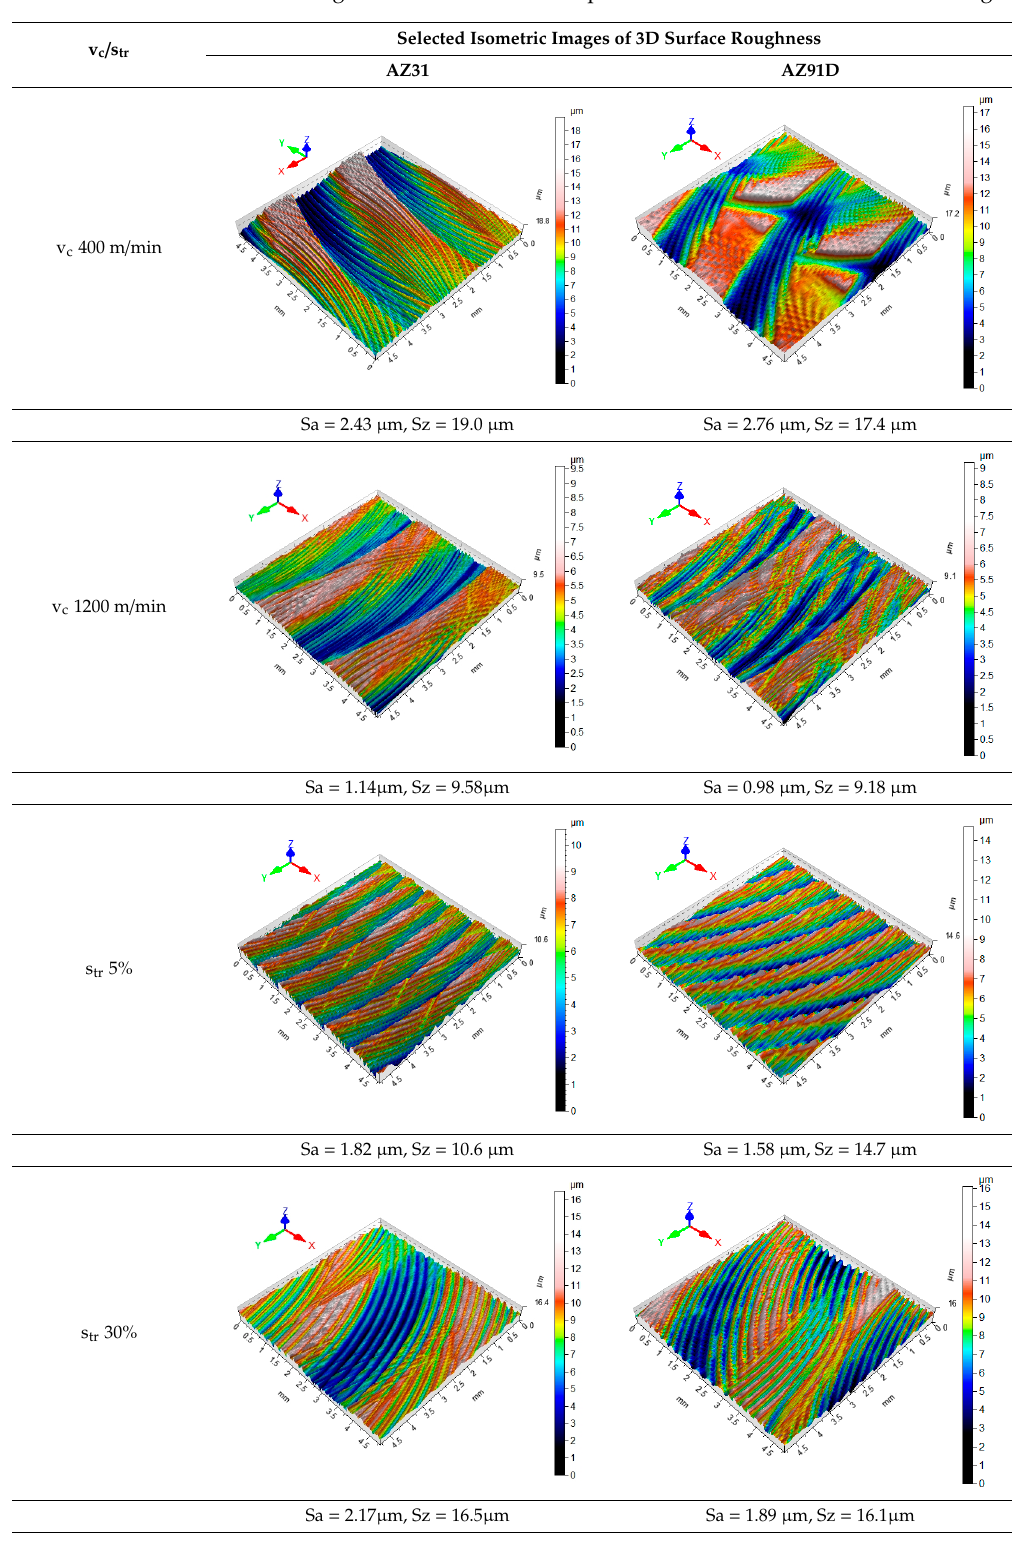
Table 3. Selected isometric images of AZ31 and AZ91D specimen surfaces after trochoidal milling. Selected Isometric Images of 3D Surface Roughness v c / s tr